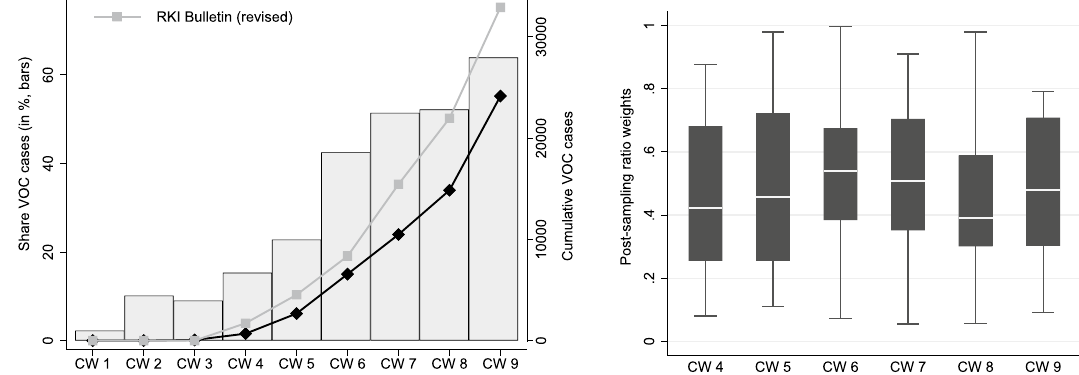
Figure 4. Comparison of cumulative VOC counts covered by different data sources in the first calendar weeks (CW) 2021. Panel ( A ) shows time-series for the development of cumulative VOC cases in Germany reported by the virus variant-tracking crowdsourcing project by 15 and those reported by German health authorities and documented in 14,24,25 later on. The time period shown covers the first 9 calendar weeks in 2021 (January 4 to March 7, 2021). Bars in Panel ( A ) measure the percentage share of VOC cases (Alpha, Beta and Gamma variants, jointly) in all submitted genomes for Germany to the Global Initiative On Sharing All Influenza Data (GISAID) hCoV-19Tracking of Variants project. Data are obtained from 10 . Panel ( B ) shows box plots for the regional distribution of post-sampling ratio (PSR) weights by calendar weeks. Details on the calculation of PSR weights exploiting differences between VOC cases covered in the crowdsourced database and the RKI bulletins for individual German federal states as shown in this figure are given in the main